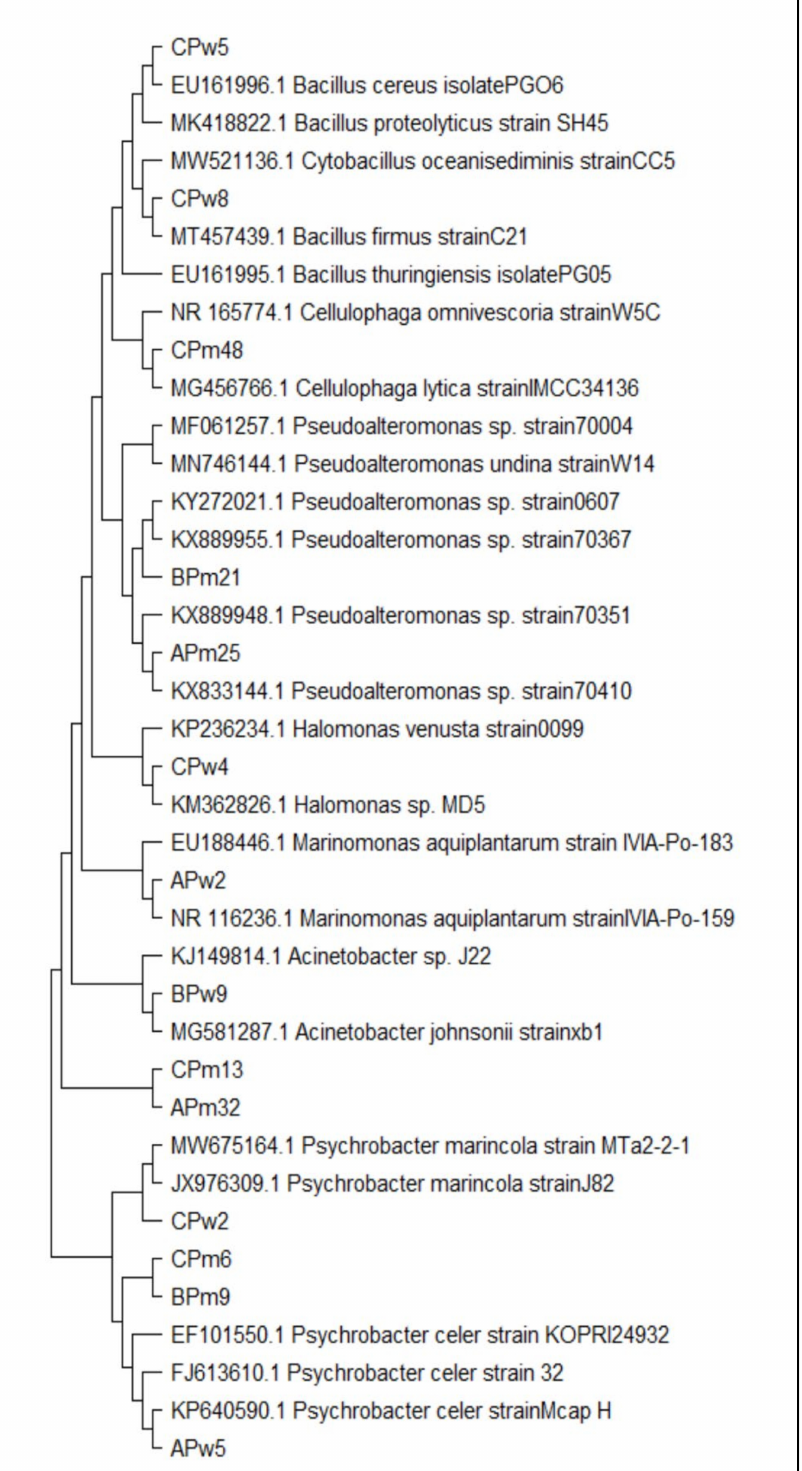
Figure 7. Phylogenetic tree for bacterial species associated with P. damicornis mucus and the surround- ing seawater. Phylogenetic analyses were conducted in MEGA11. There were a total of 2303 positions in the final dataset. A: Industrial Zones, B: Public Beach, C: Phosphate Berth, P: P. damicornis , m: mucus, w: